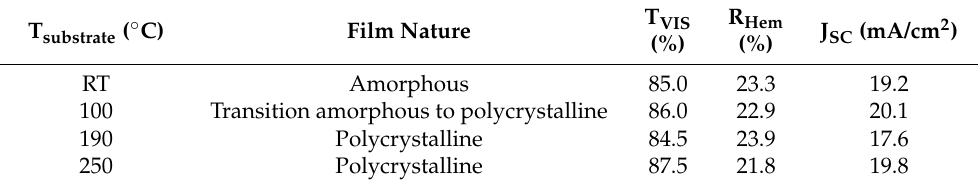
Table 4. Main optical parameters of the ITO films deposited at 25 W and 0.17 Pa as function of the substrate temperature. The nature of the films and the J SC of the photocells are also included.